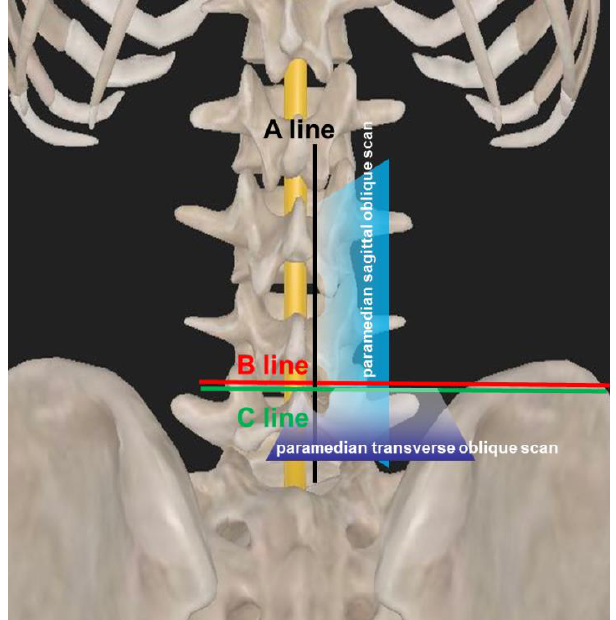
Figure 5. Schematic diagram illustrating the difference between the B line and the C line, and how the ultrasound penetrated the patient via the paramedian sagittal/transverse oblique scan approach.